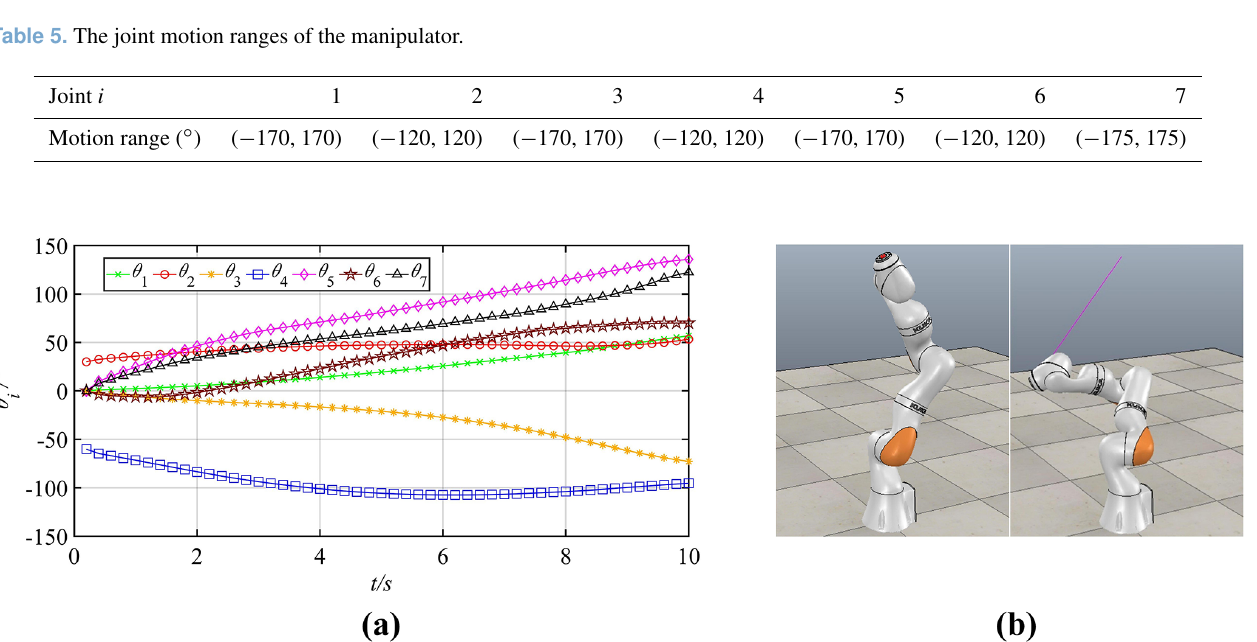
Figure 19. Joint motion curves and simulation process. (a) Joint motion curves. (b) Initial and target poses.